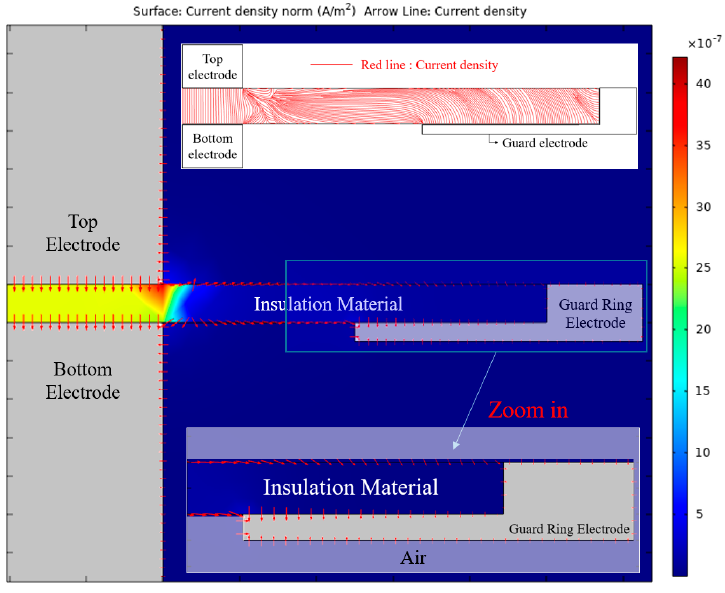
Figure 8. Current density simulation of the guard-ring terminal electrode structure for measuring the insulator resistivity.